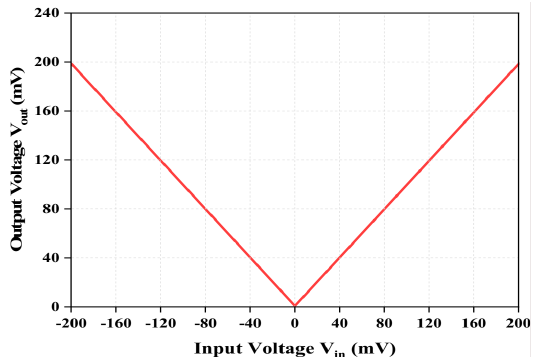
Figure 5. DC Voltage transfer characteristic of the proposed full-wave rectifier